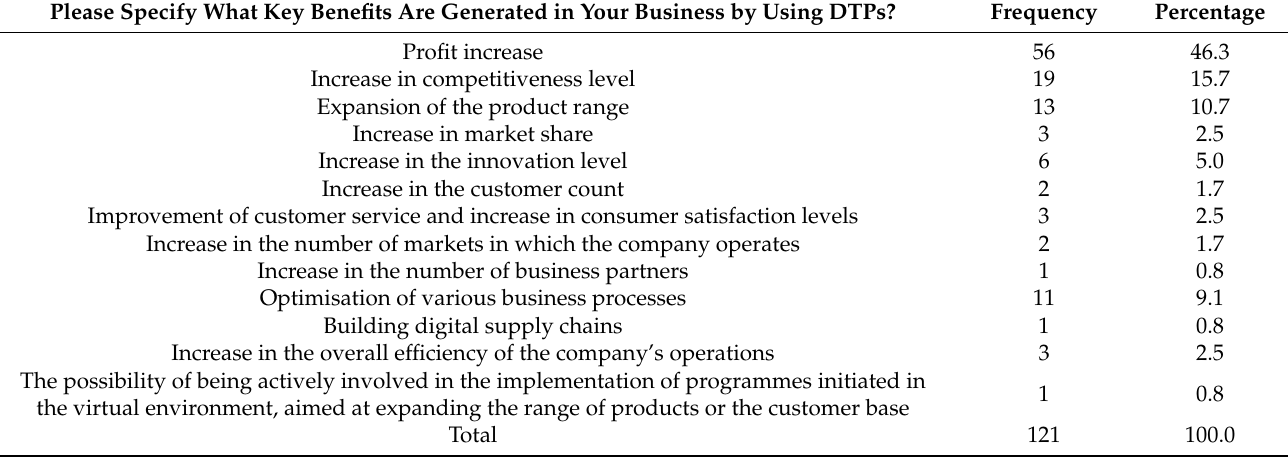
Table 4. The benefits of using DTPs.